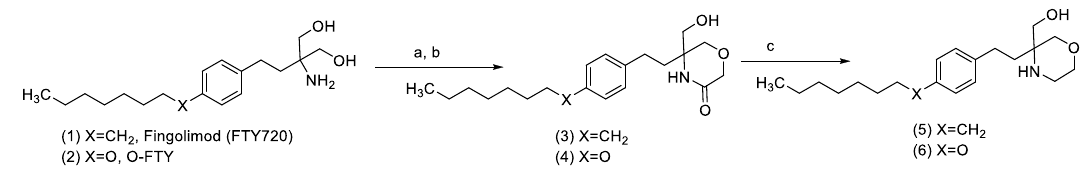
Figure 11. Synthesis of ST 1893 and ST-1894. ( a ) Triethylamine, chloroacetyl chloride, tetrahydrofuran (THF); ( b ) NaH, THF; ( c ) LiAlH 4 , THF.